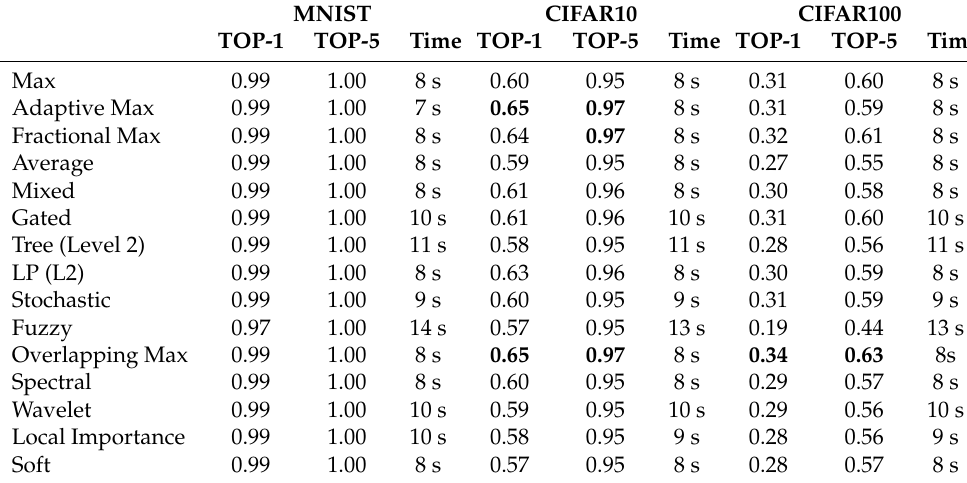
Table 5. The top 1/top 5 validation accuracy and time required per epoch for each model.